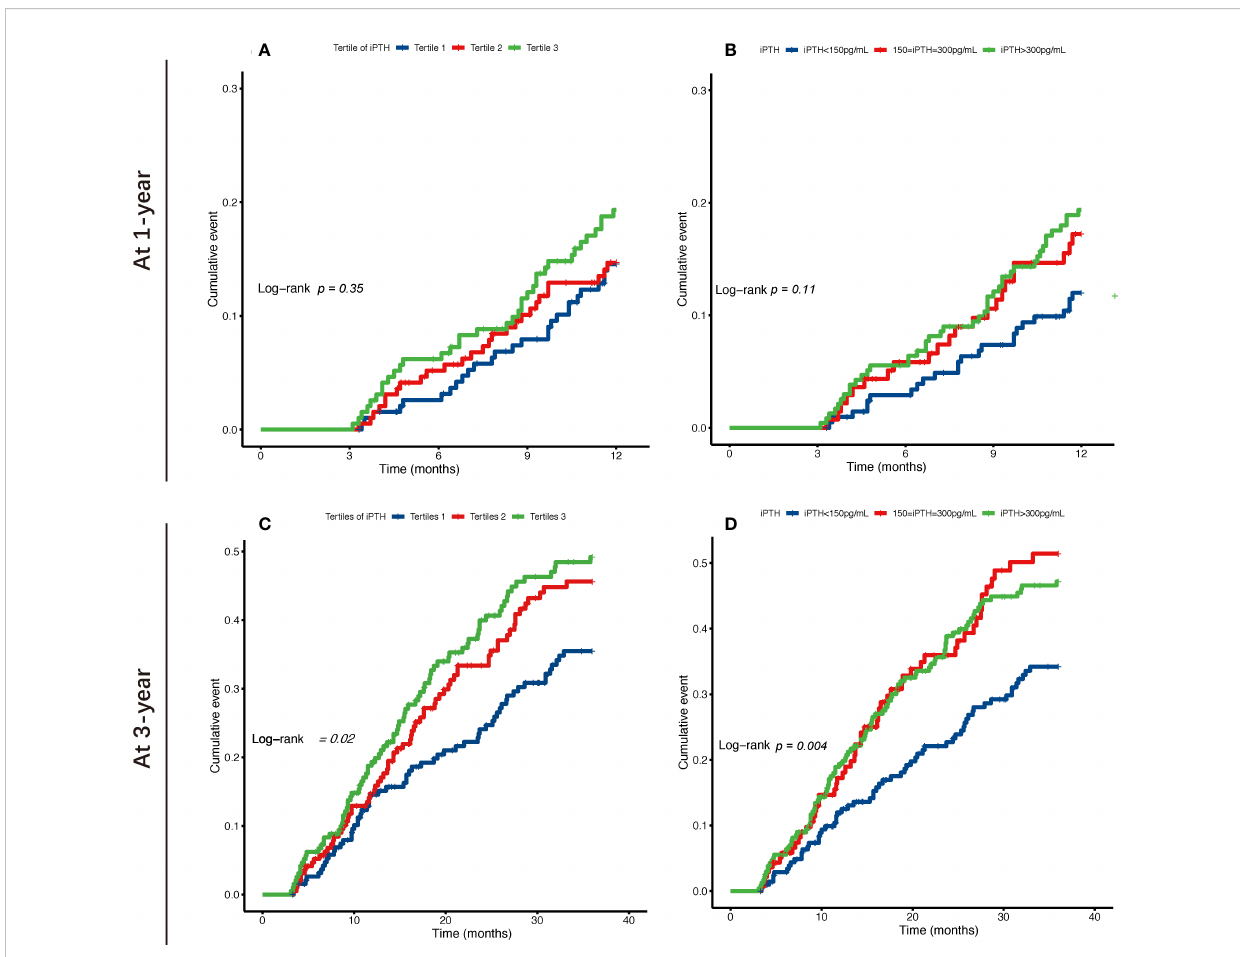
FIGURE 2 Kaplan – Meier survival curves of the risk of occurrence of fi rst peritonitis episode at 1 and 3 years for tertiles (A, C) and categories by 150 – 300 pg/ml (B, D) of the serum intact parathyroid hormone (iPTH) levels in patients undergoing continuous ambulatory peritoneal